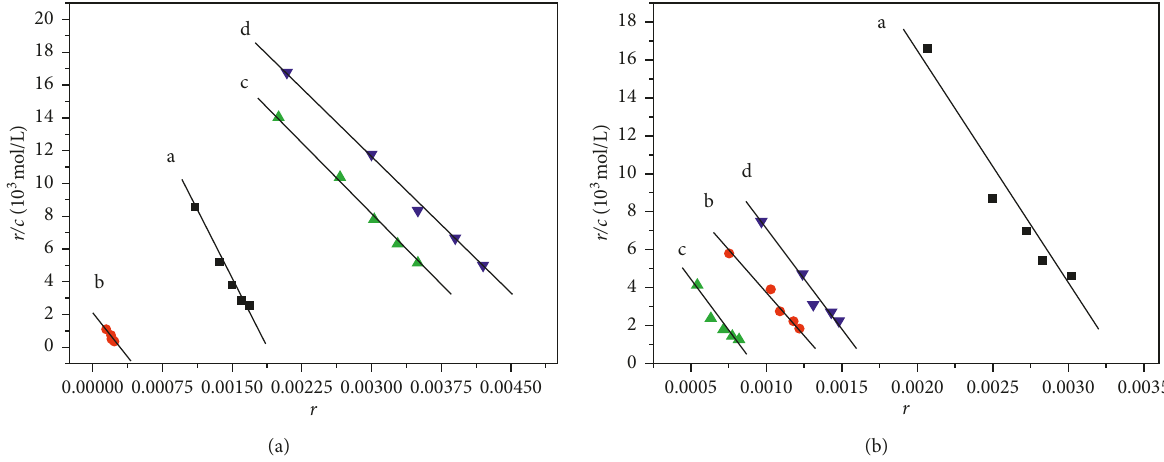
5 mol 1 (10 μ L per scan, 1–18: 0–170 μ L); (b) fluorescence spectra of DNA-4S Green system in L · − − 4 mol 1 (10 μ L per scan, 1–18: 0–170 μ L · − −